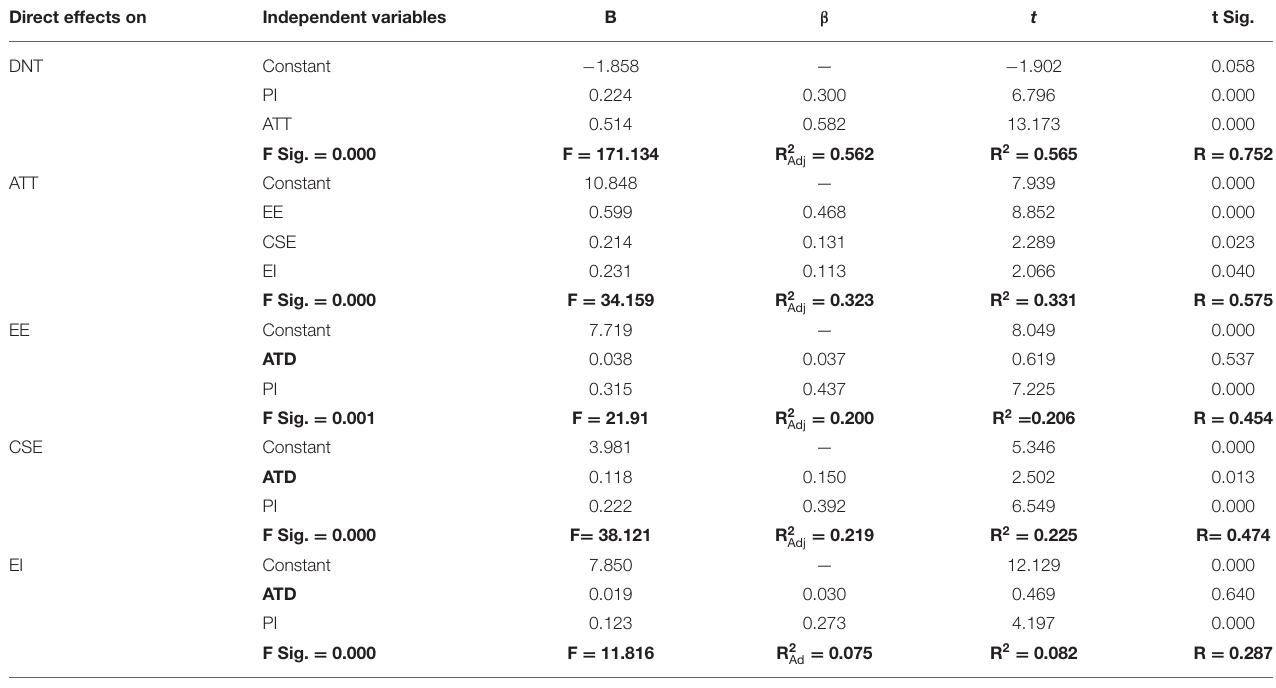
TABLE 4 | Direct effects on DNT, PI, and ATT. Direct effects on